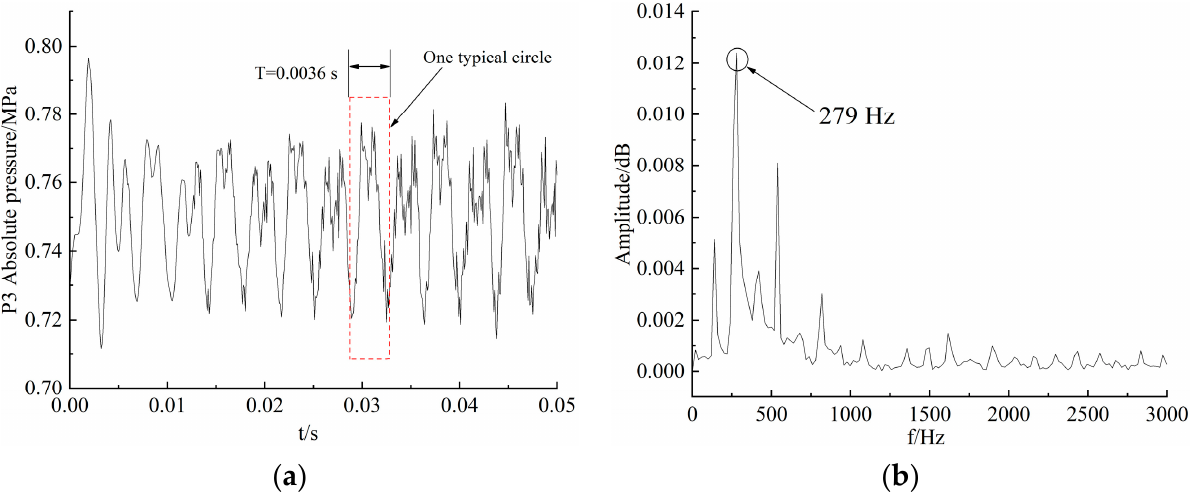
Figure 20. Variations in the absolute pressure of the P3 measuring point in the time and frequency domain ( SR = 0.01): ( a ) absolute pressure, ( b ) absolute pressure spectrum.